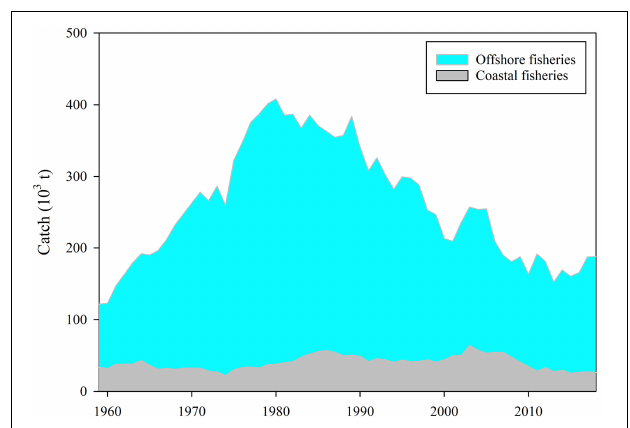
FIGURE 2 | Catches of Taiwan coastal and offshore marine capture fisheries from 1959 to 2018. Data source: Fisheries Agency (1949–2019).